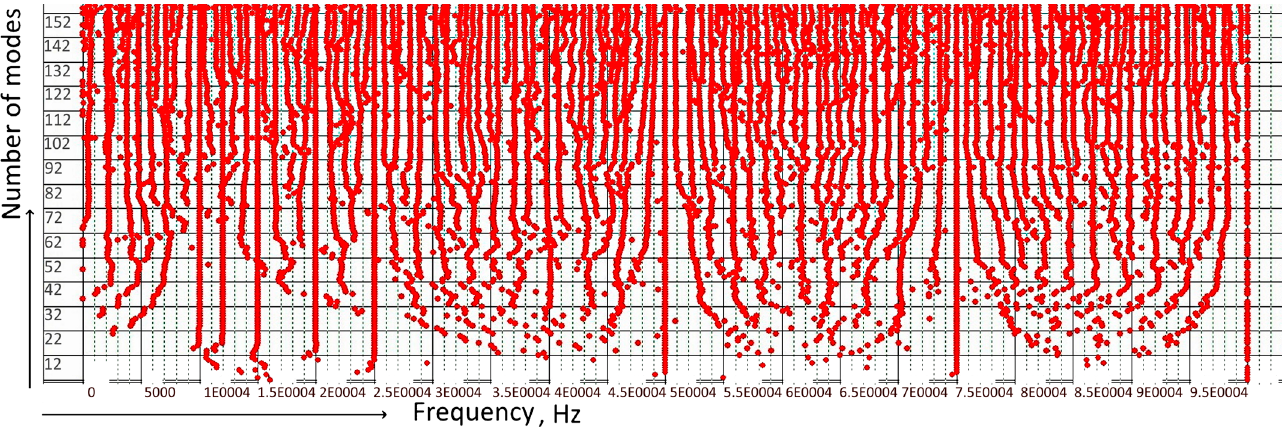
Figure 9. Stabilization diagram for frequency estimates of the model process. The horizontal axis exhibits frequency, and the vertical axis—the number of modes (model complexity), i.e., the number of components in the approximation model, which may be much larger than in the original test model.